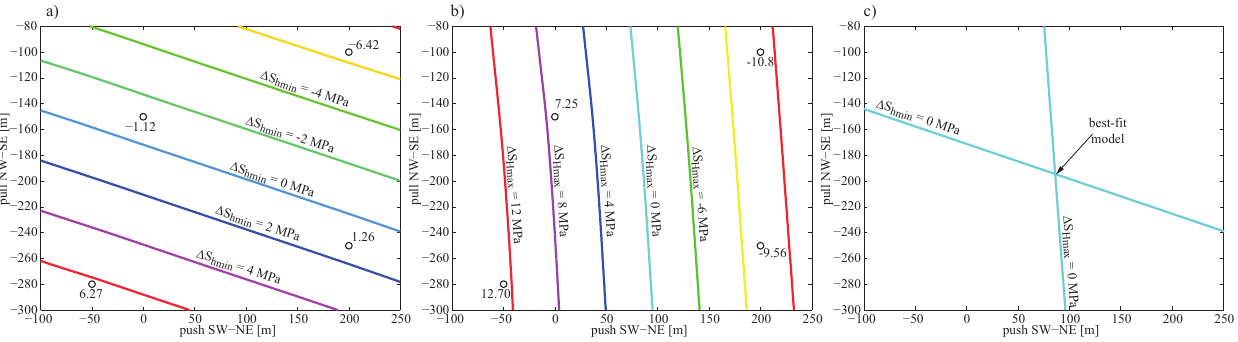
the mean values ( (cid:49)S hmin = 0.03 and (cid:49)S Hmax = − 2.76).